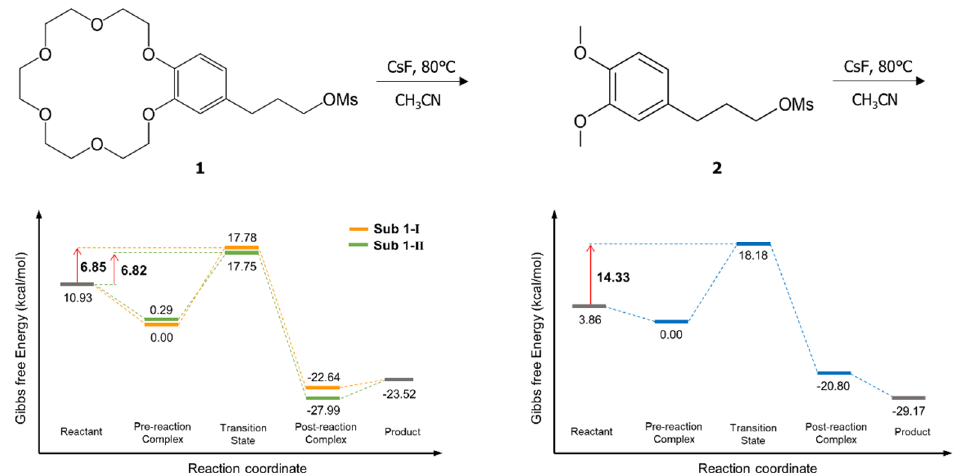
Figure 2. Energetics of S N 2 fluorination of 1 and 2 using CsF. Gibbs free energy in kcal/mol.